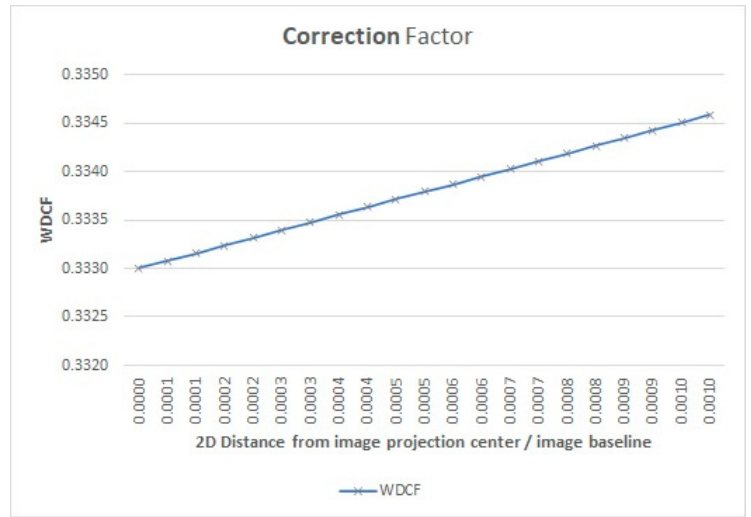
Figure 7. Compensation of Water Depth Correction factor.